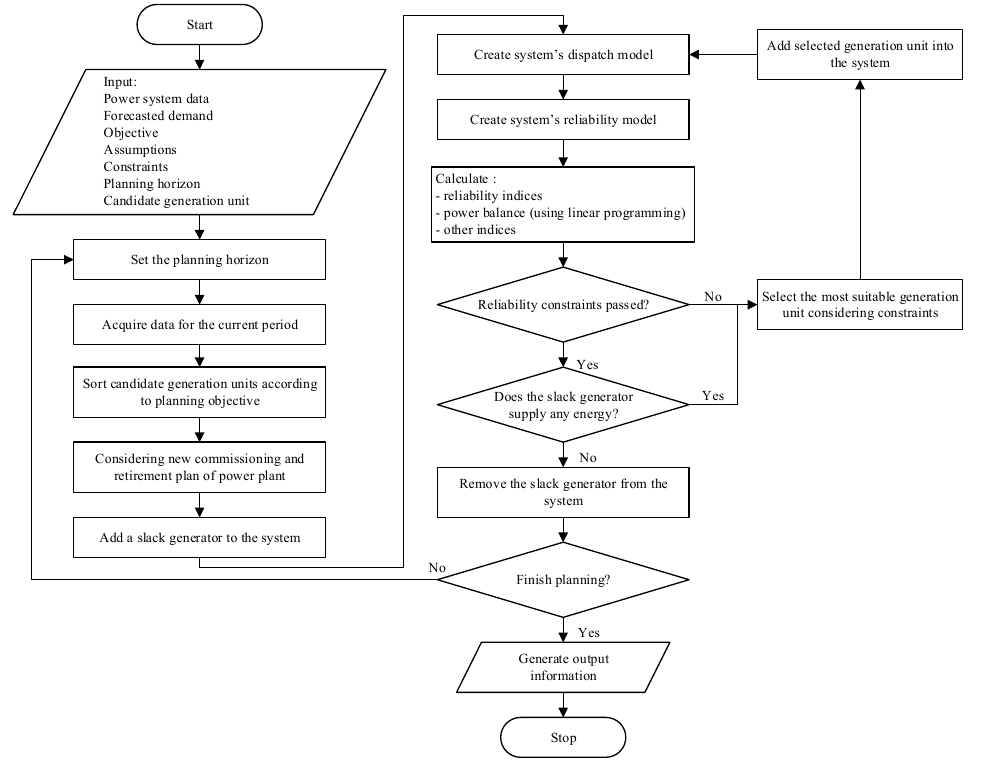
Figure 1. Flow chart of generation expansion planning used in this paper.